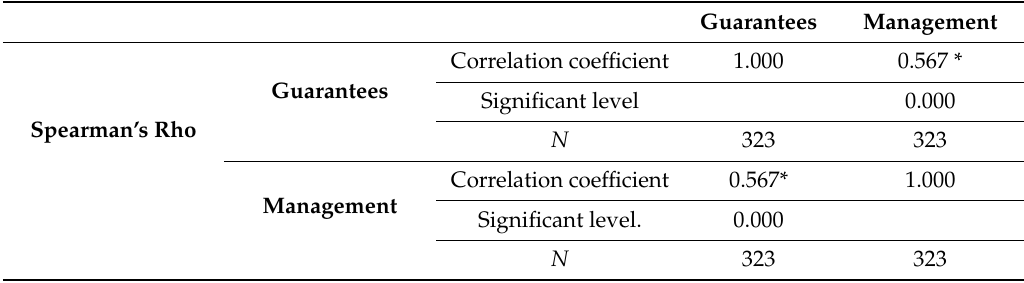
Table 7. Correlations between guarantees and